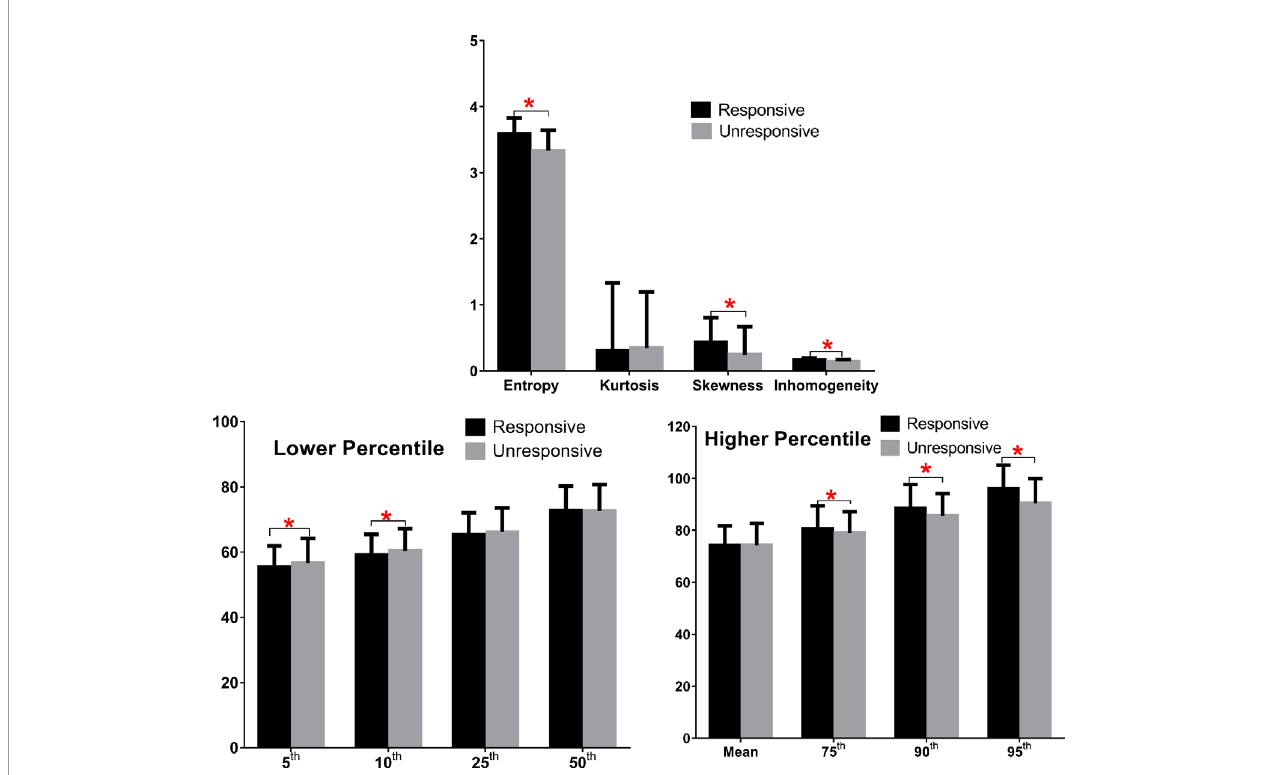
FIGURE 2 | Comparison of baseline histogram-based texture metrics of EOMs for the two groups of patients with TAO. The * stand for the p value of the comparison was less than 0.05, or, had signi fi cant statistical